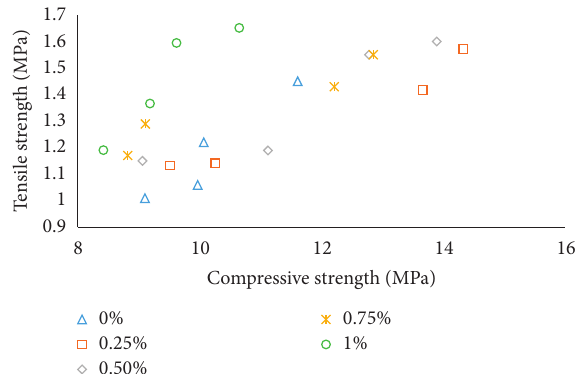
Figure 7: Relationship between compressive strength and tensile